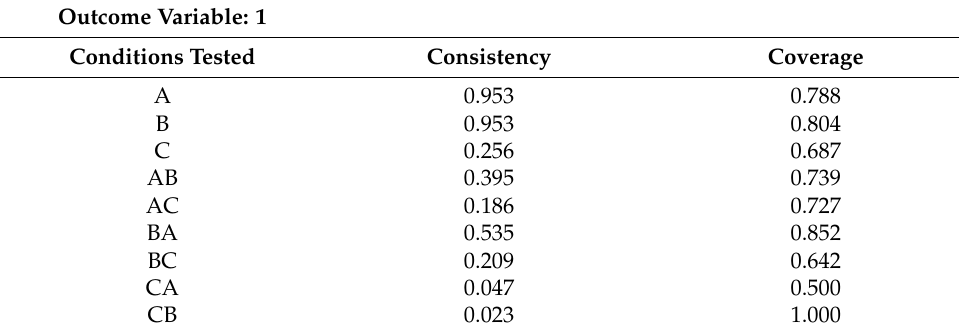
Table 2. Results of necessity tests (Hazard